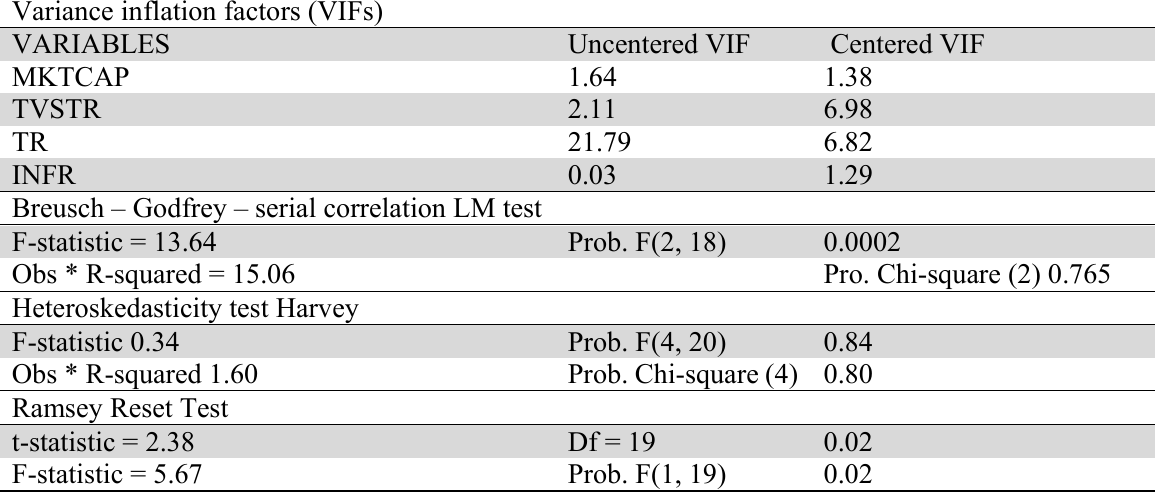
Diagnostic tests